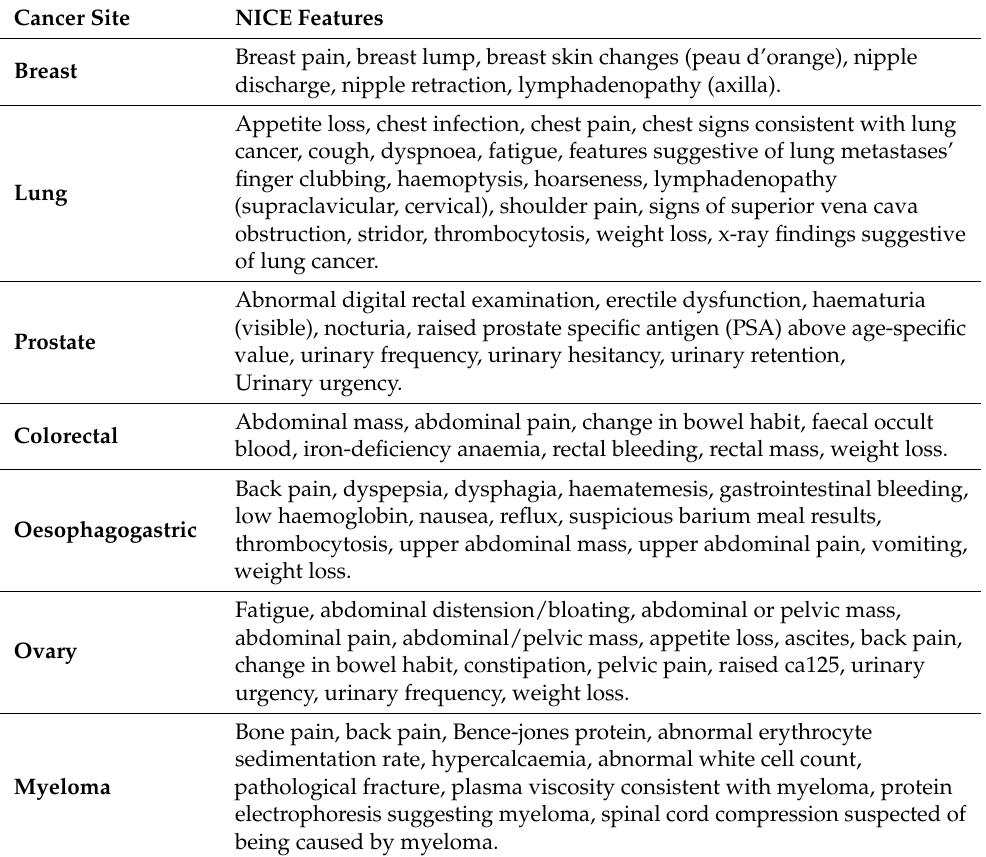
Table 1. Cancer features sought in participants’ medical records in the year before